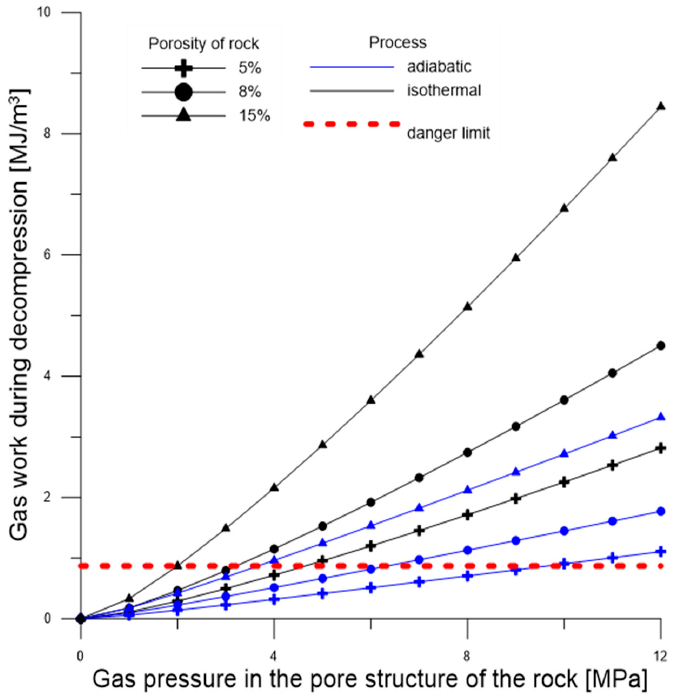
Figure 10. Work released during the decompression of gas from the porous structure of rock as a function of the pressure and porosity, shown with the theoretical minimum work required to disintegrate and transport the rock.